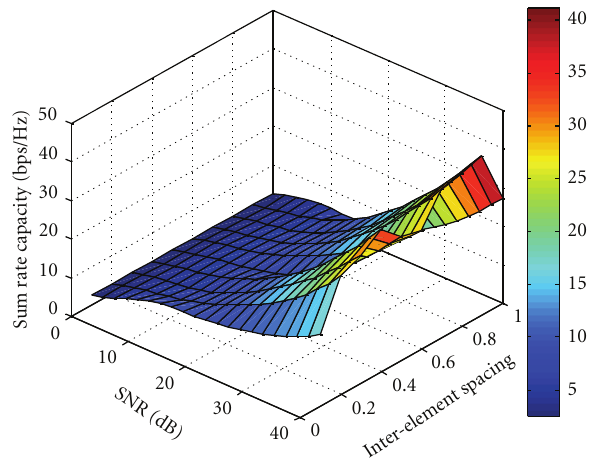
Figure 2: Surface of sum rate capacity with regard to interelement spacing at BS and SNR for a 2 × (3 × 6) multiuser MIMO system without mutual coupling taken into account.